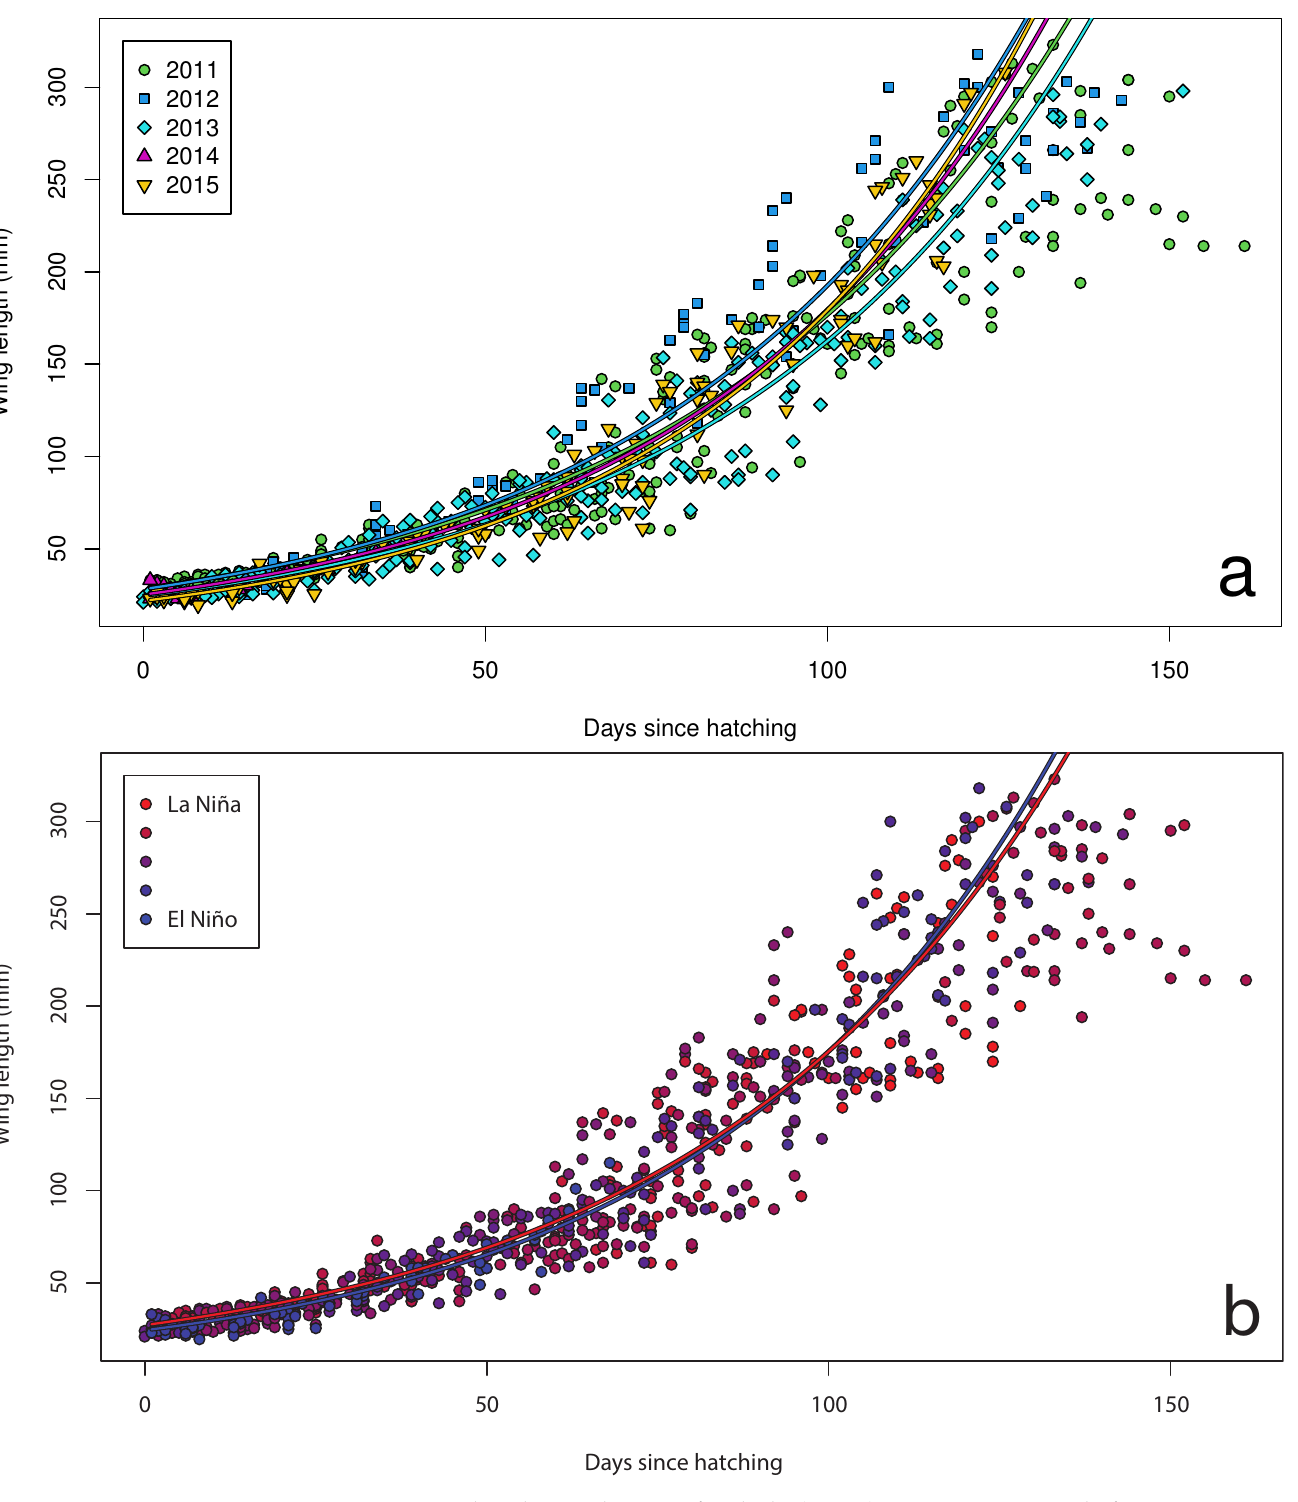
Figure 4. Wing length growth curves for chicks ( n = 72) on Te H¯awere-a-Maki from 2011 to 2015: ( a ) annually; ( b ) monthly Southern Oscillation Index. Lines of best fit indicate years and SOI = –1 or